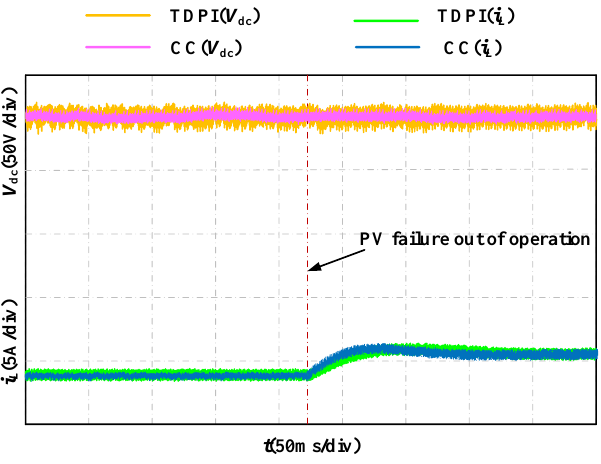
( b ) Figure 11. Experimental results for sudden change in reference voltage. ( a ) V dc ref suddenly increases to 225 V; ( b ) V dc ref suddenly decreases to 210 V. Obviously, the proposed CC method shows lower overshoot, faster response speed, and shorter stability time than the TDPI when tracking voltage reference V dc ref changes. This confirms that the proposed control strategy has better transient and steady-state